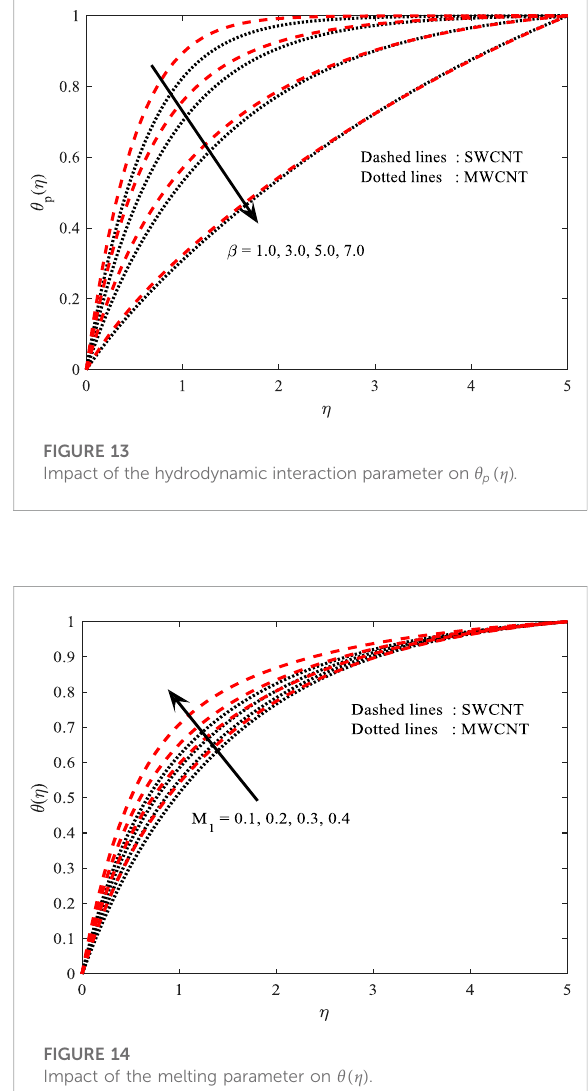
FIGURE 12 Impact of the hydrodynamic interaction parameter on θ ( η ) .